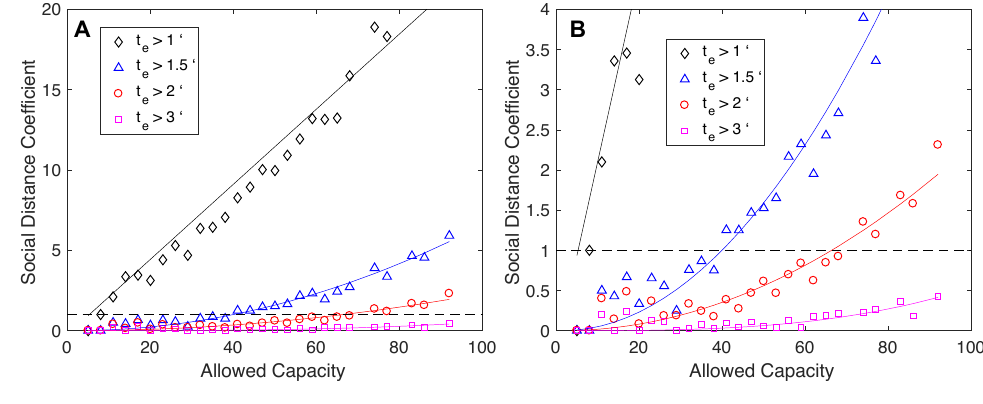
Figure 9: A: Physical distance coefficient as a function of supermarket occupation for the second simulation hour. B: Close up of previous figure showing details near δ π ∼ 1. Solid lines correspond to the theoretical approach presented in section